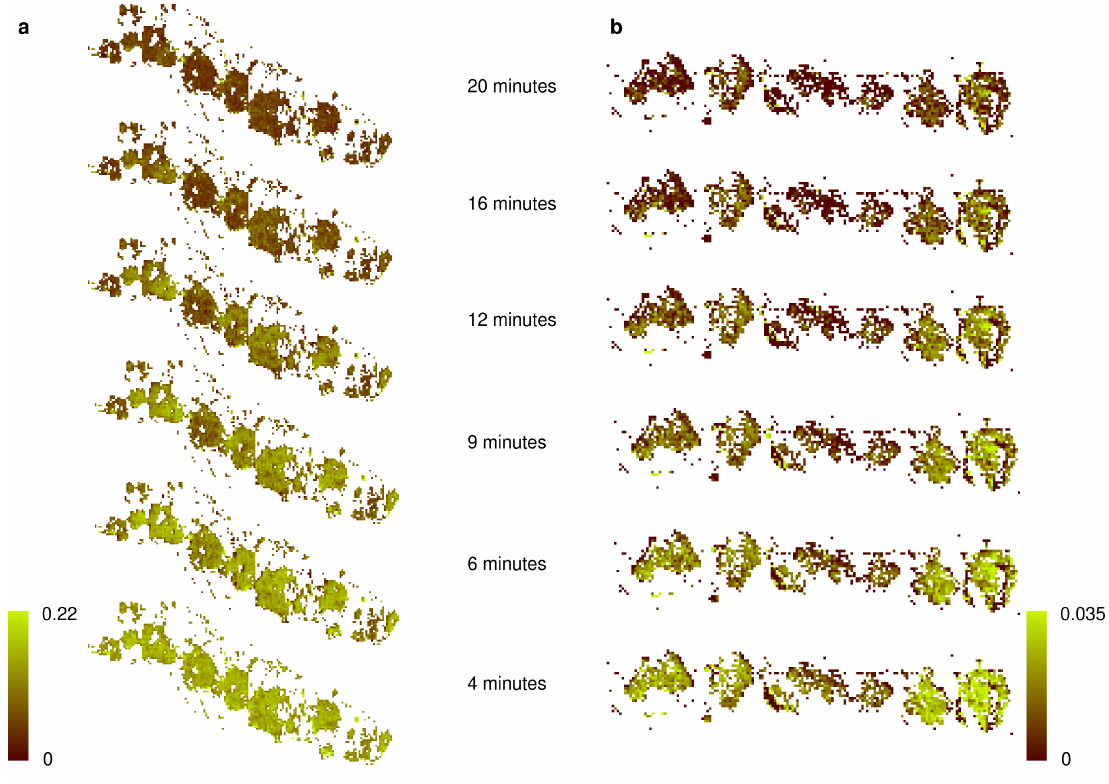
Figure 9. Predictions of NP in µ mol CO 2 g − 1 s − 1 based on hyperspectral field data for Acarospora cf. gypsi-deserti ( a ) and Caloplaca santessoniana ( b ) during drying-out. Time is given in minutes after the BSCs have been